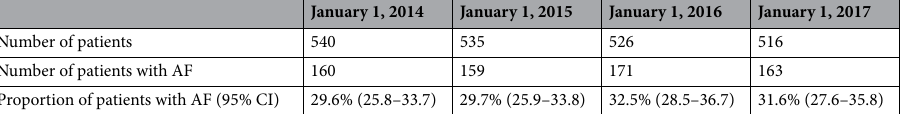
Table 2. Point prevalences of AF from year 2014 to 2017 on January 1. AF, atrial fibrillation; CI, confidence interval.